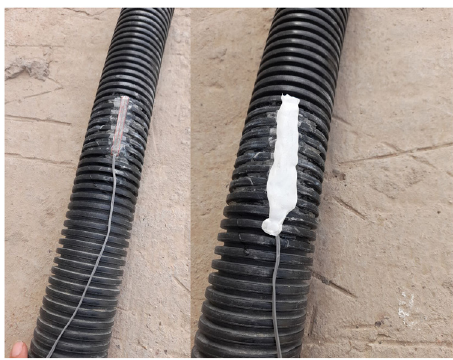
Figure 2: Corrugated pipe.